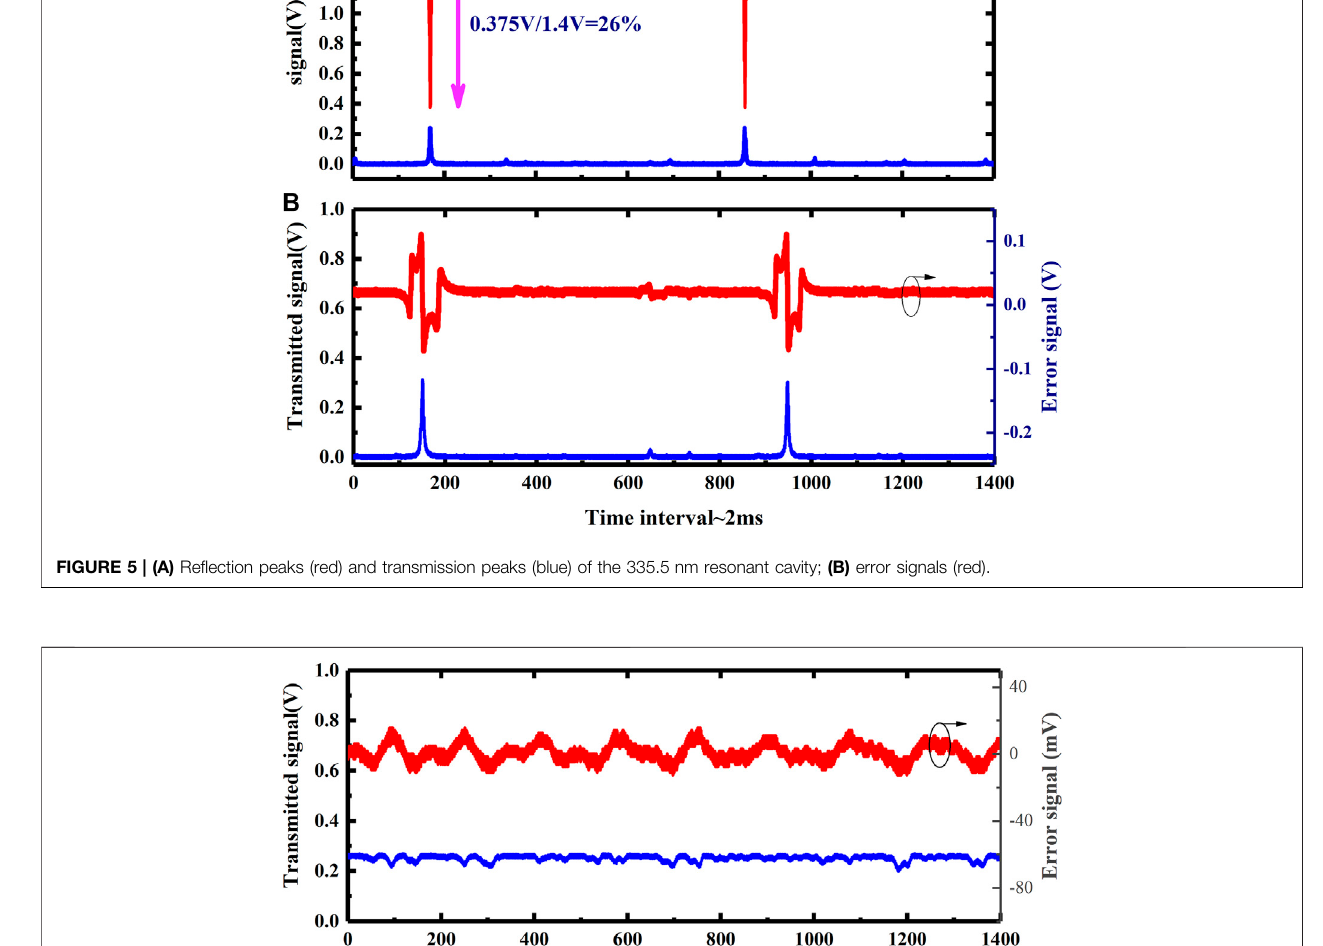
Frontiers in Physics |